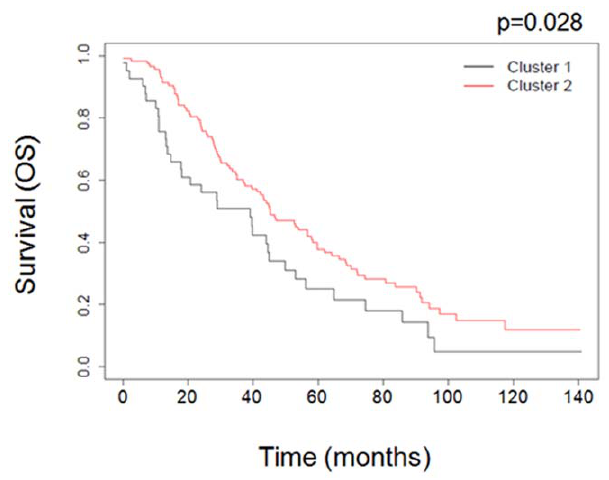
Figure 4. Validation of classification accuracy in UCSF-GOG dataset. Kaplan-Meier plot for UCSF-GOG subgroups identified through supervised clustering. Subgroups are clinically distinct with regard to overall survival (p=0.028).